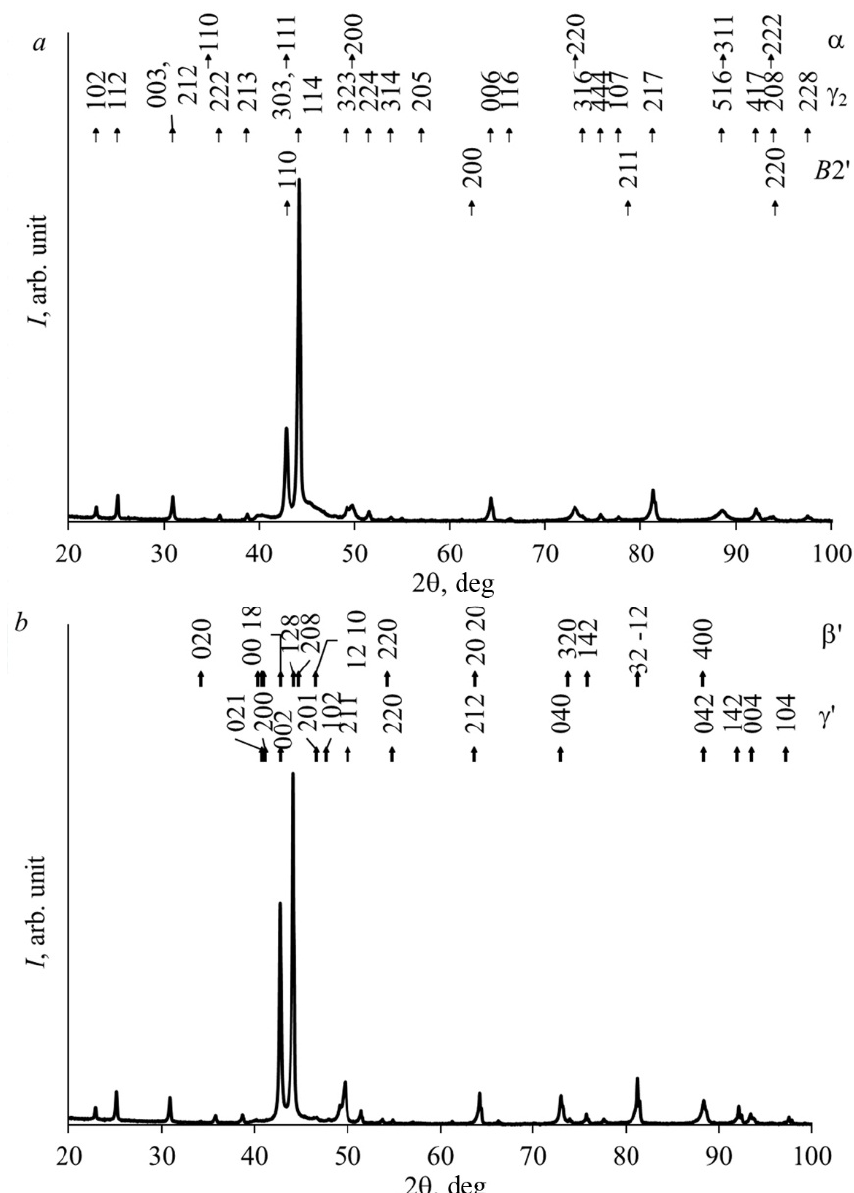
Figure 5. X-ray diffraction patterns for the Cu–14Al–4Ni alloy taken after MPC with v = 1 mm/min at ( a ) 673 and ( b ) 873 K.